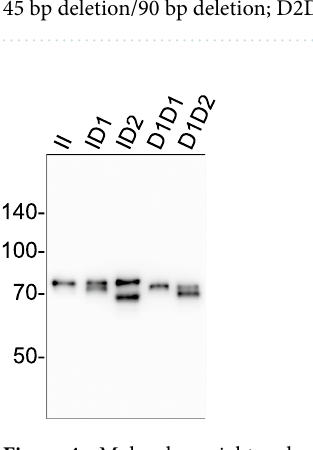
Table 2. Actual and expected values of each eHRG genotype in Thoroughbred horses. II, Insertion/insertion; ID1, Insertion/45 bp deletion; ID2, Insertion/90 bp deletion; D1/D1, 45 bp deletion/45 bp deletion; D1D2,